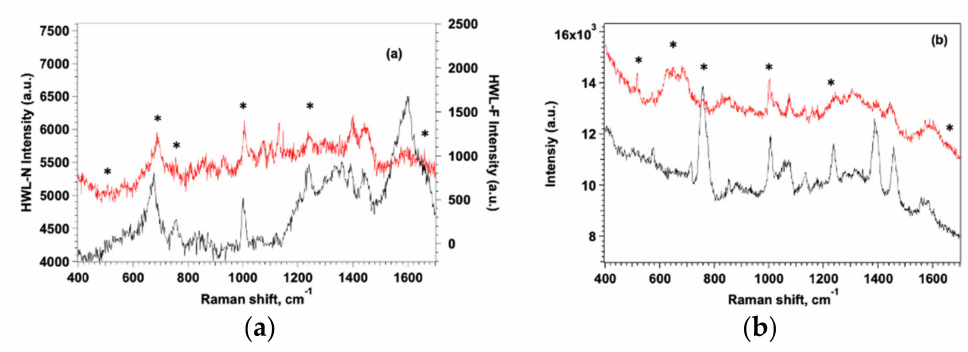
Figure 6. SERS spectra of HWL-N (black line) and HWL-F (red line) on AgNC/NS ( a ) and GO-AgNC/NC ( b ) platforms. [lysozyme] = 1 × 10 − 6 M. Distinctive peaks are marked by